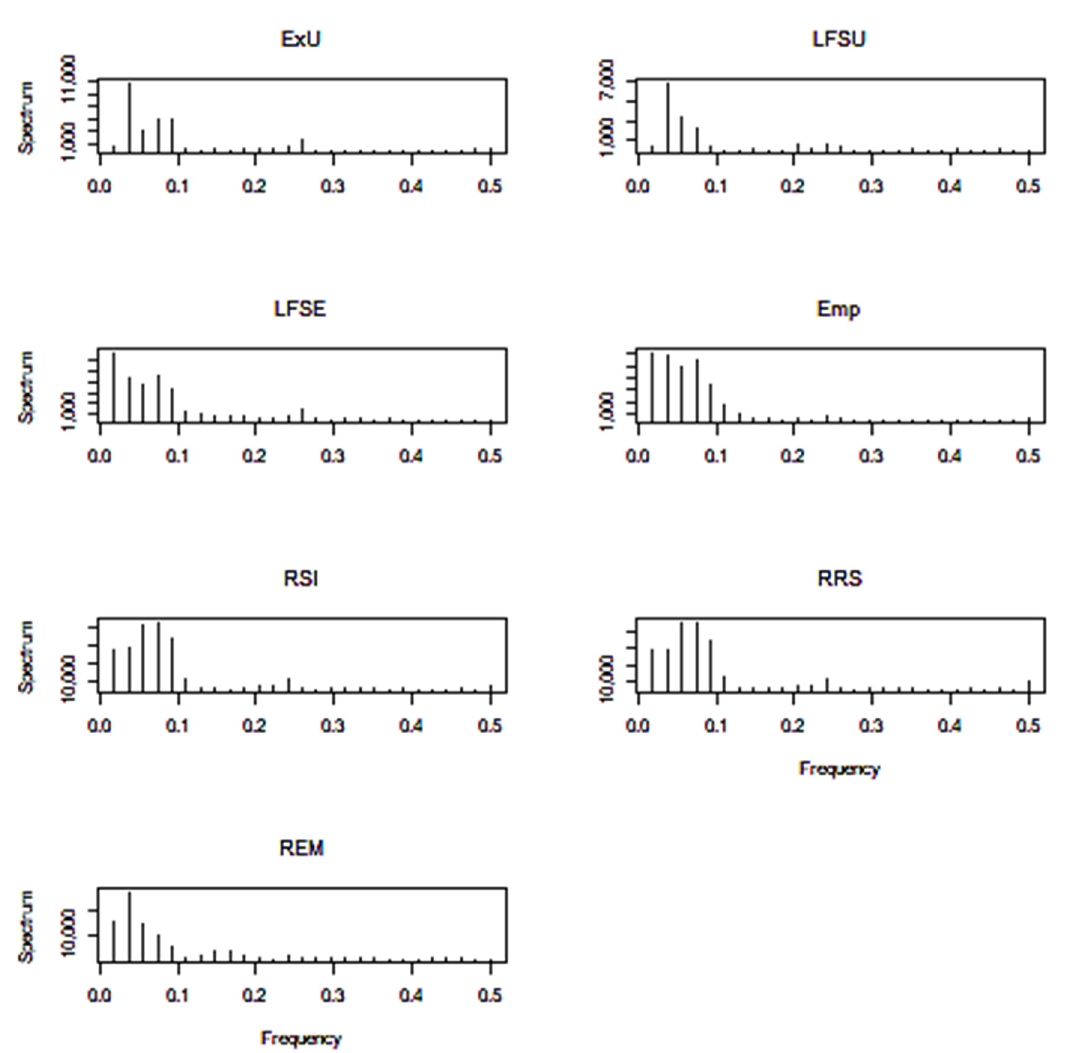
Figure 4. Periodograms. Figure 4.